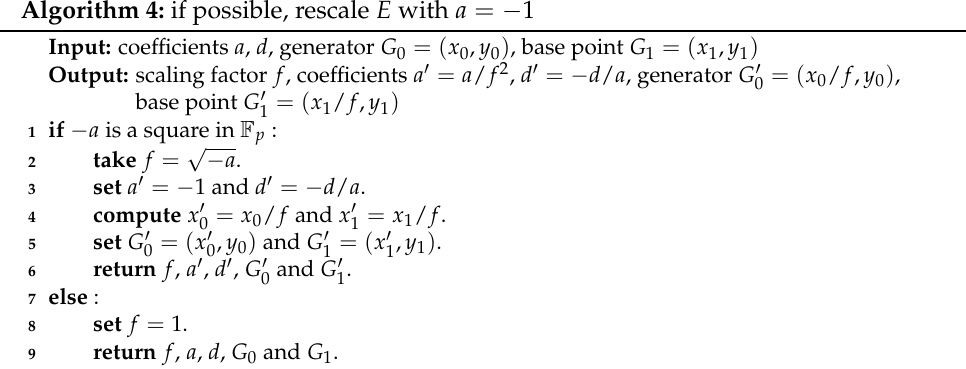
Algorithm 4: if possible, rescale E with a =